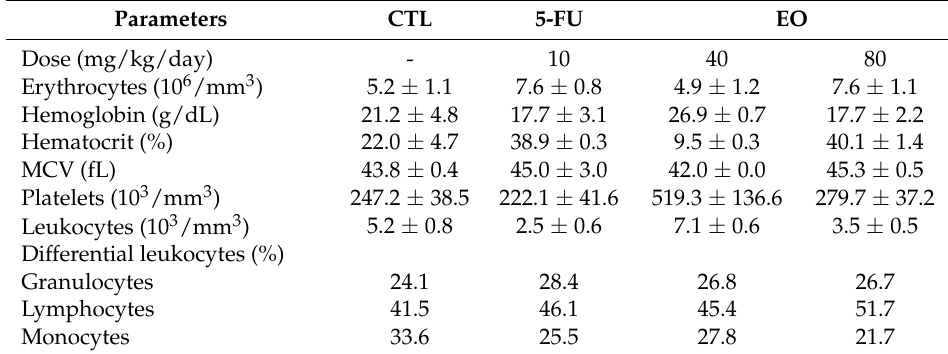
Table 4. Effect of the essential oil (EO) from the leaves of Croton matourensis on hematological parameters of peripheral blood from C.B-17 SCID mice with HepG2 cell